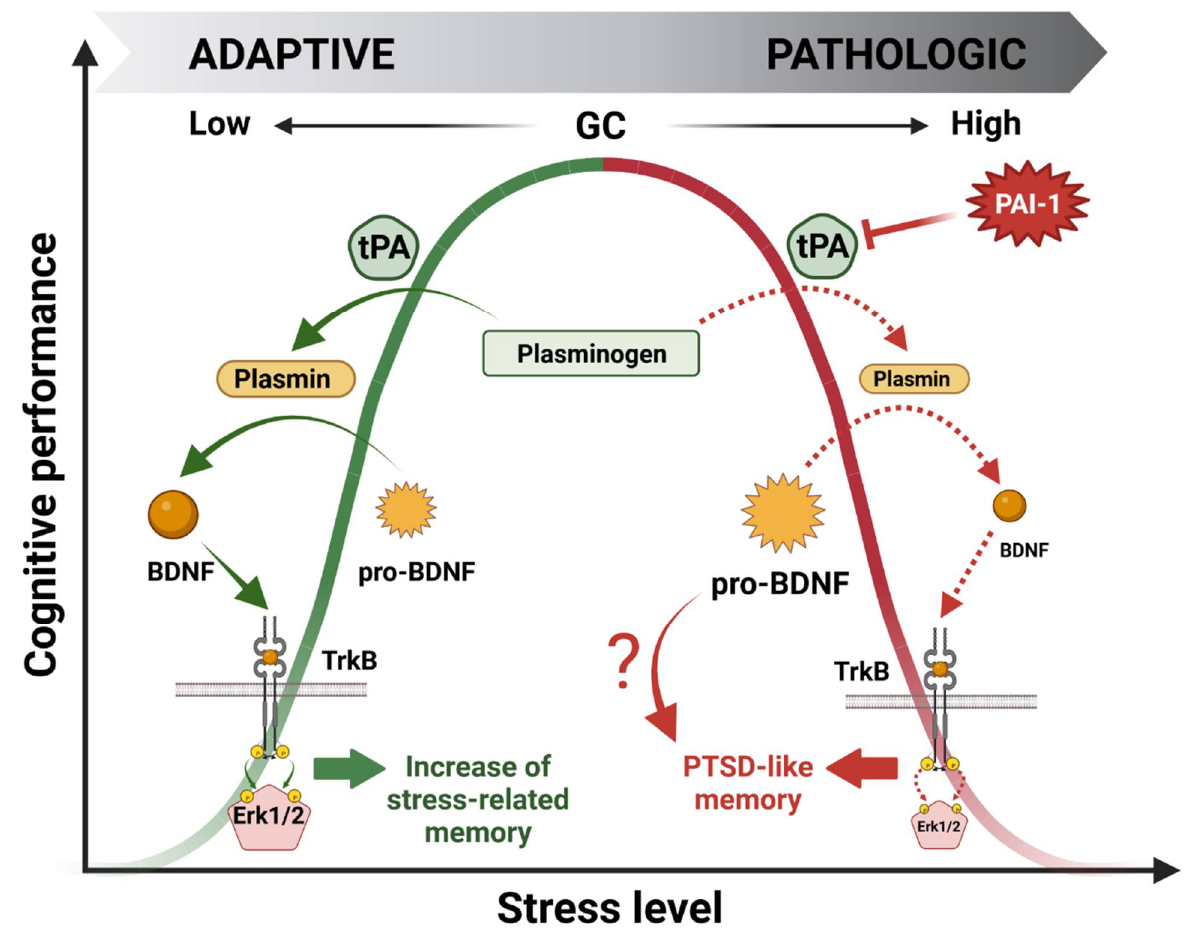
Figure 4. Molecular mechanisms underlying the beneficial (green) and deleterious (red) bell-shaped effects of glucocorticoid hormones (GCs) on stress-induced memory performance.